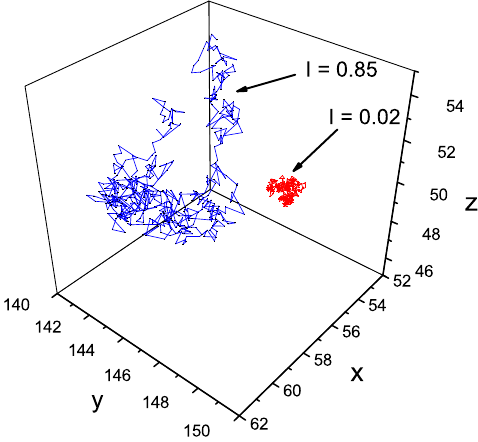
Figure 4. Exemplary trajectories of CM of chains for different illumination intensity, I 0 = 0.85 and I 0 = 0.02, for a system with constant